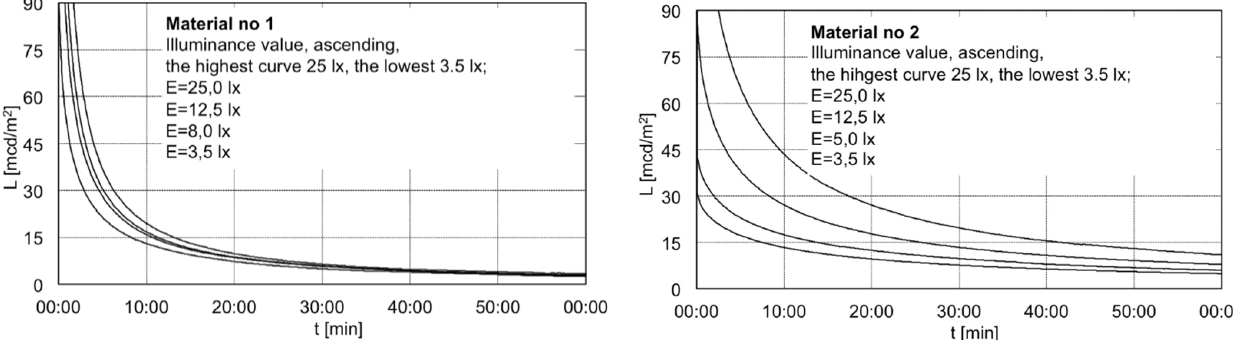
Figure 5. Example curves presenting luminance change in time after the disappearance of the excitation source for the 840 fluorescent lamp.